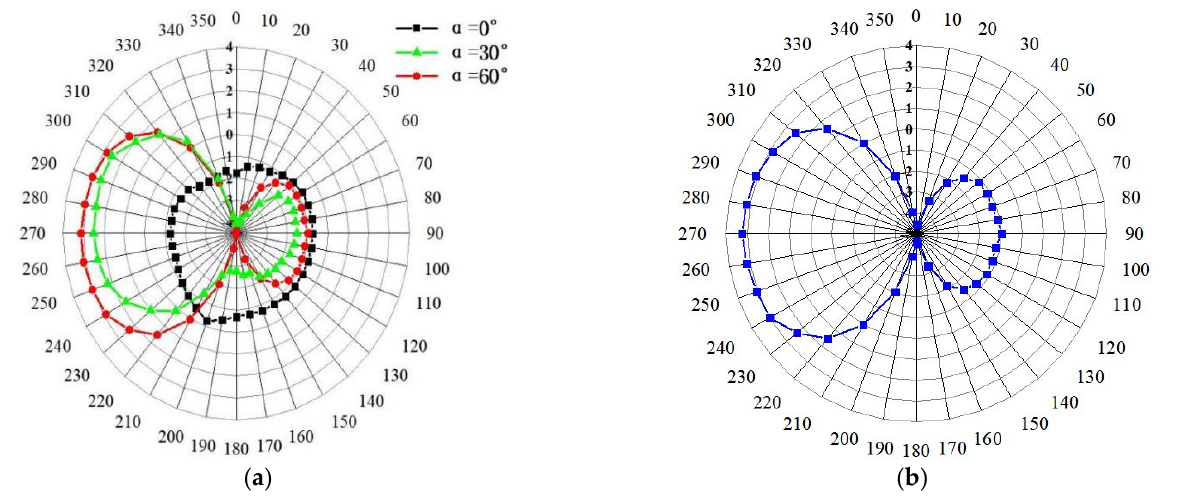
Figure 8. ( a ) Wind-pressure coefficient of disturbance-area section; ( b ) wind-pressure coefficient of non-disturbed Section. non-disturbed Section.